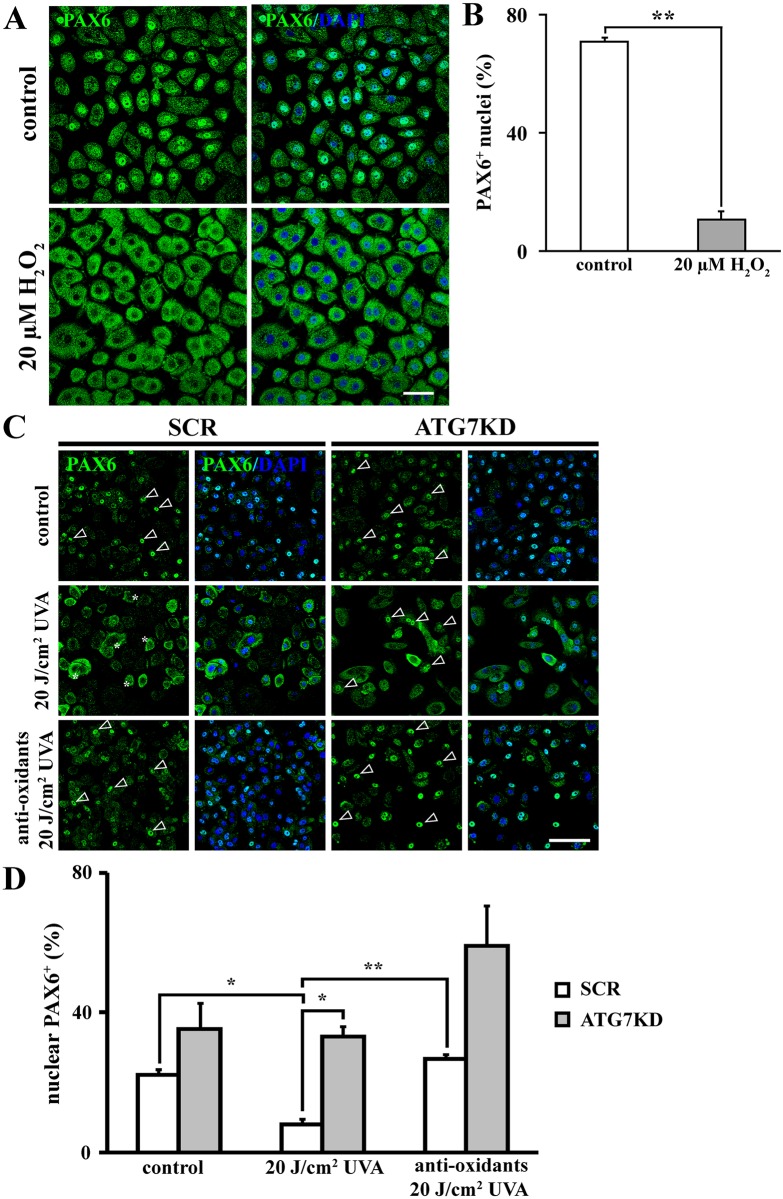
Autophagy mediates nuclear export of PAX6 in response to UVA-elicited oxidative stress.(A) Representative immunofluorescent images depicting subcellular localization of PAX6 in controls and H2O2-treated LSCs. Scale bar, 50 μm. (B) Quantification of cells expressing nuclear PAX6 after H2O2 treatment. (C) Representative micrographs of PAX6 subcellular localization in LSCs exposed to UVA with or without antioxidant pretreatment. Arrowheads indicate nuclear localization of PAX6, asterisks denote cytoplasmic distribution of PAX6. Scale bar, 100 μm. (D) Percentage of LSCs expressing nuclear PAX6. *p < .05, **p < .01.